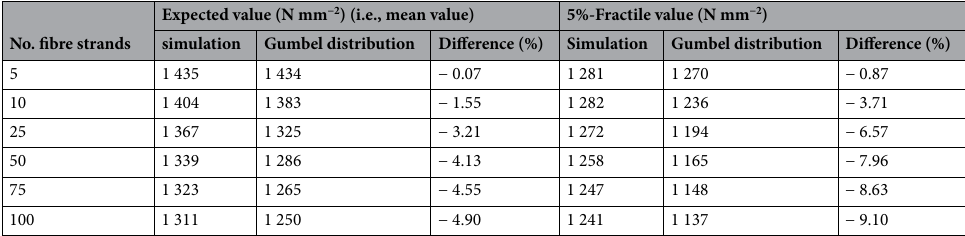
Table 2. Ultimate tensile strength: Comparison of the simulations and the theoretical investigations.